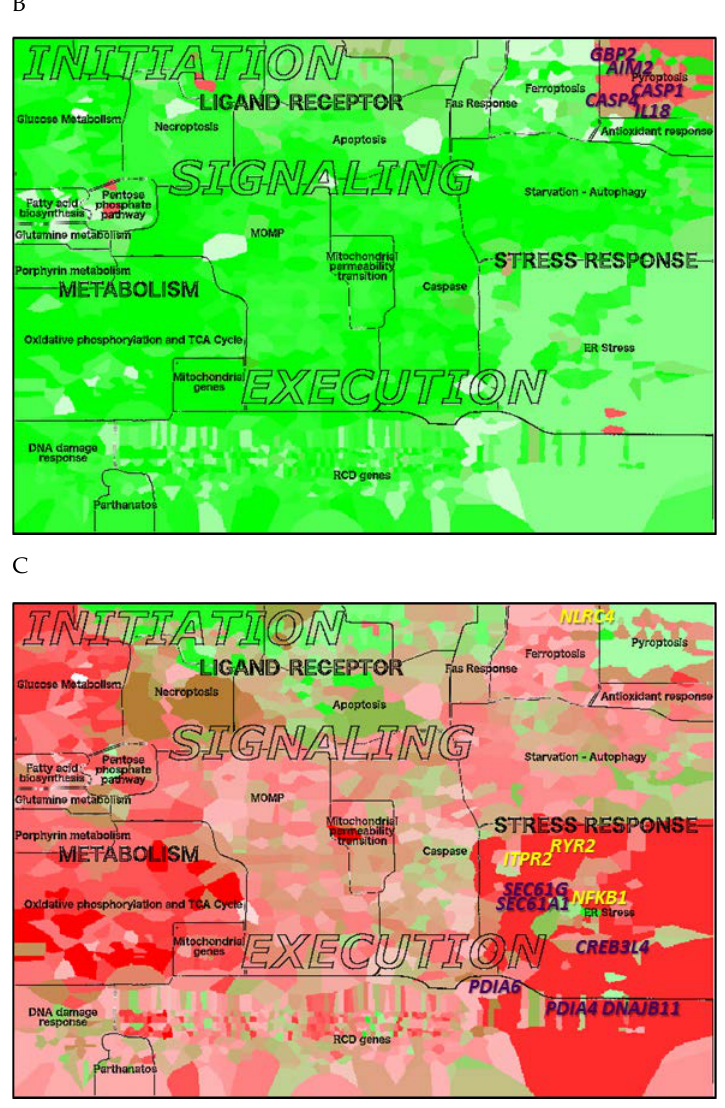
Figure 5. Visualization of average ROMA modules activity scores using expression data from Alzheimer disease (AD) hippocampus samples and non-small cell lung cancer (NSCLC) specimens in the RCD map. ( A ) Heatmap representing ROMA scores for the two diseases (each respective to its normal controls). Staining of RCD map with ROMA scores from ( B ) AD data and ( C ) NSCLC data. The plotted values correspond to the relative ROMA module score compared to controls (as in A). Top contributing genes are represented in their locations on the map, purple positively contributing genes and yellow negatively contributing genes.